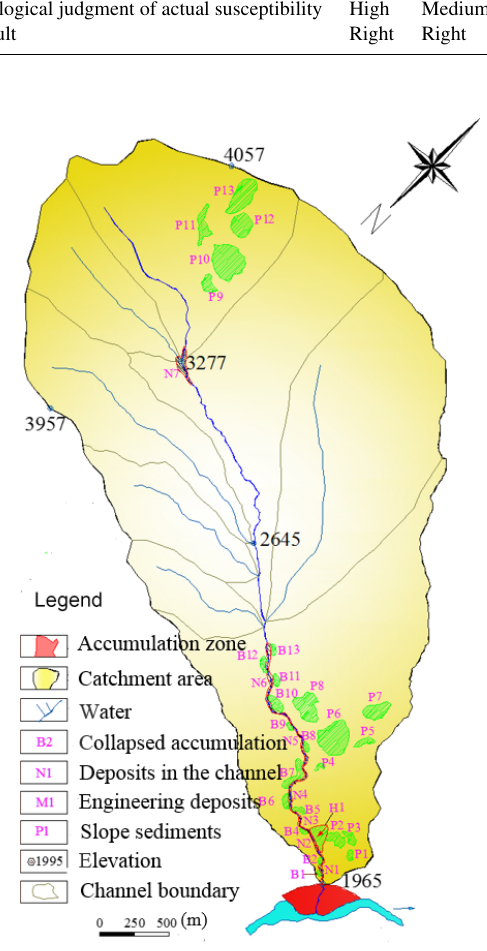
Figure 8. Distribution of loose deposits of Linong Gully.